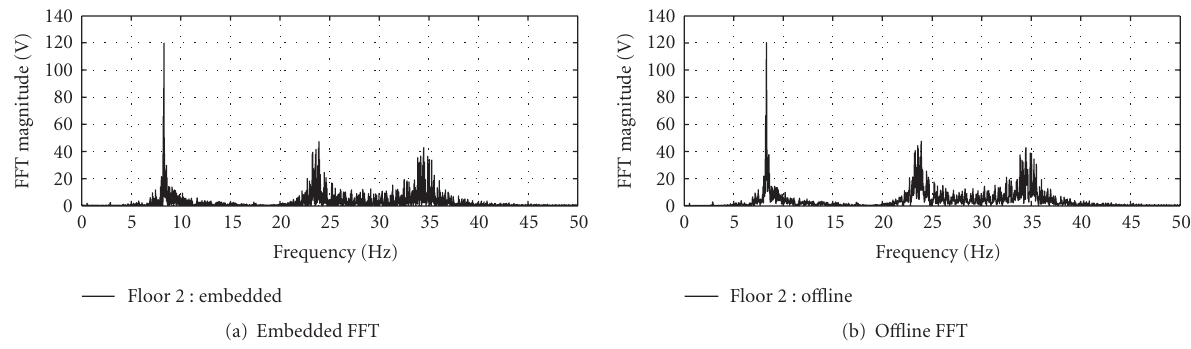
Figure 4: Comparison of FFT results. (a) Embedded using the wireless sensing unit. (b) O ffl ine using